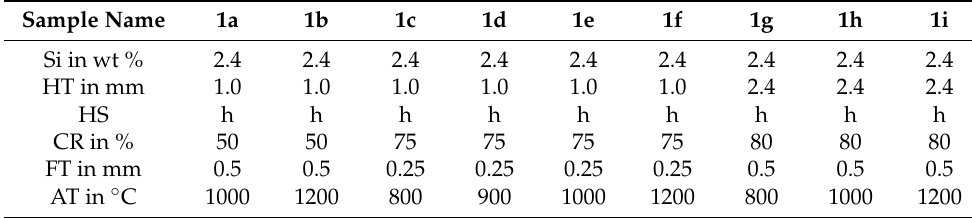
Table 1. Overview and sample names of the processing routes for the Fe–2.4 wt % Si.